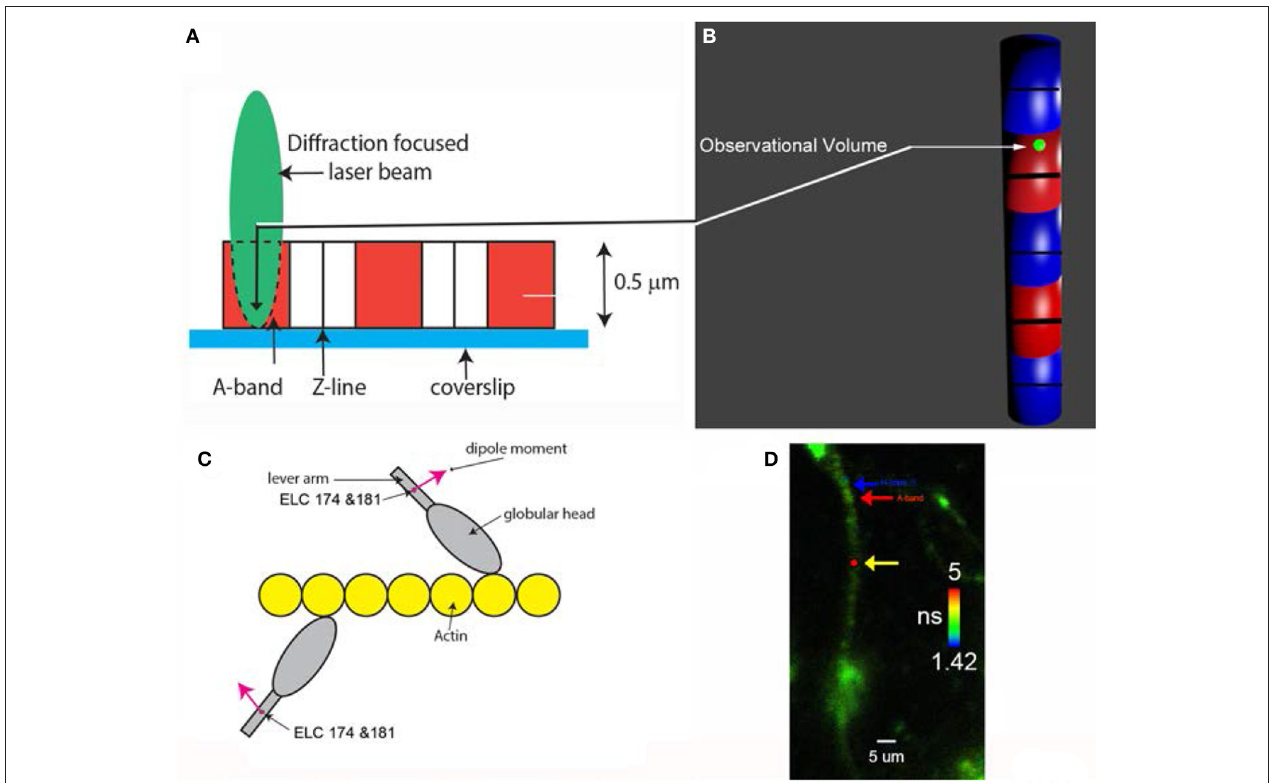
FIGURE 2 | (A) A diffraction limited laser beam (green ellipsoid) is focused on an isolated myocyte sitting on a coverslip. A confocal microscope sees only the Observational Volume (OV, outlined by a broken line). The A-band (red) is the only region where the interaction between actin and myosin occurs. (B) Fluorescence is collected from the OV shown here in 3D as a green sphere imbedded in the A-band. It is projection of the confocal aperture on the image plane. The diameter of the OV (0.5 µ m) is equal to the diameter of the confocal pinhole (50 µ m) divided by the magnification of the objective (100x). Myosin within the A-band is fluorescently labeled (red). The I-bands are non-fluorescent (blue). Thick black lines are the H-zones; thin black lines are the Z-bands. The myocyte contracts (i.e., develops normal force), but does not shorten because it is cross-linked (see Methods); (C) One in approximately one thousand myosin molecules within the thick filament is labeled at LC Cys 174 and Cys 181. The transition dipole moments the dye of two labeled myosins are marked in magenta. Emission dipoles of the dye attached to these two cysteines point in the same direction. Labeling of only 1 in a 1,000 myosins ensures that there are only 6 myosin molecules in the OV (see Methods). Actin monomers (yellow) are non-fluorescent. (D) Fluorescent lifetime image of a myocyte from a non-failing human RV in rigor myocytes were imaged by fluorescent lifetime imaging because a lifetime image is of better quality than a confocal image. Nevertheless, the quality of the image is poor because of intentionally inefficient labeling (see Methods). On the average only ∼ 6 myosin molecules/half-sarcomere were labeled with the fluorophore (see Methods). The color bar indicates lifetime (in nanoseconds) of a given pixel. The non-fluorescent part (H-zone) is pointed to by the blue arrow. Data was collected from the red spot (pointed to by the